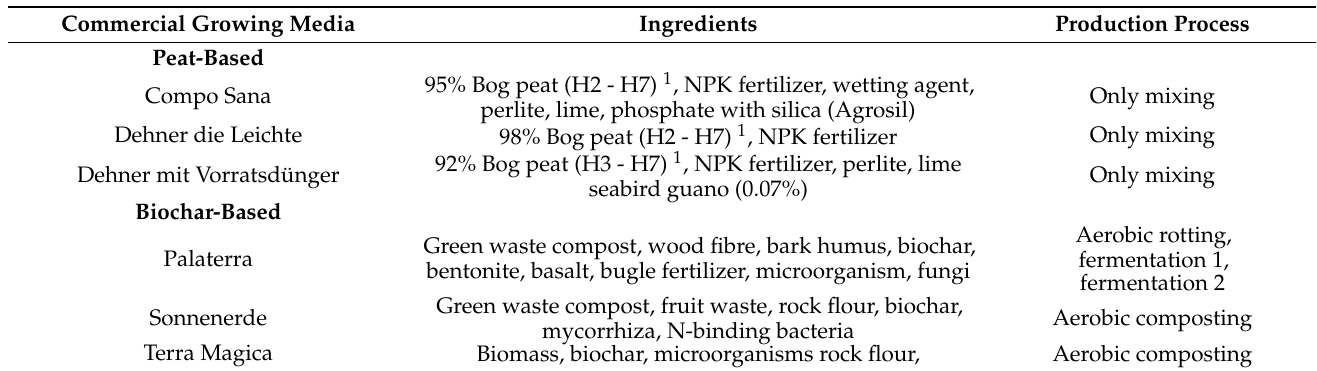
Table 1. Ingredients and production processes of commercially available peat- and biochar-based growing media used in this study according to information of